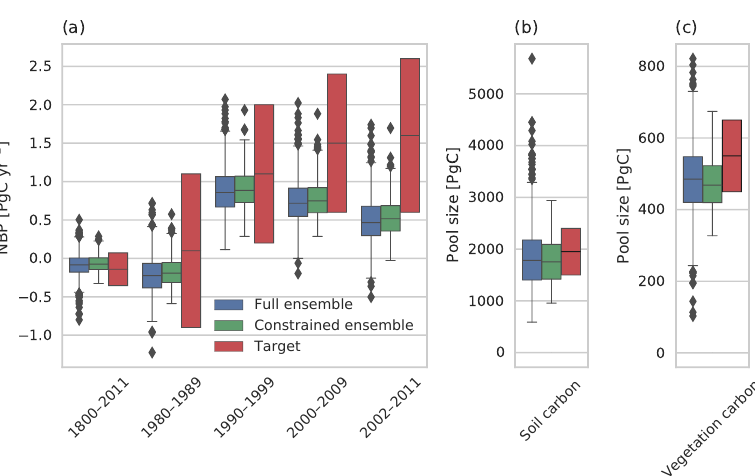
Figure 9. The value and uncertainty of the scalar targets (red) compared to an unweighted histogram of the full (blue) and constrained (green) ensemble M net , net . Panel (a) shows the net biome production in five periods; panels (b, c) show the global soil and vegetation carbon inventories respectively.